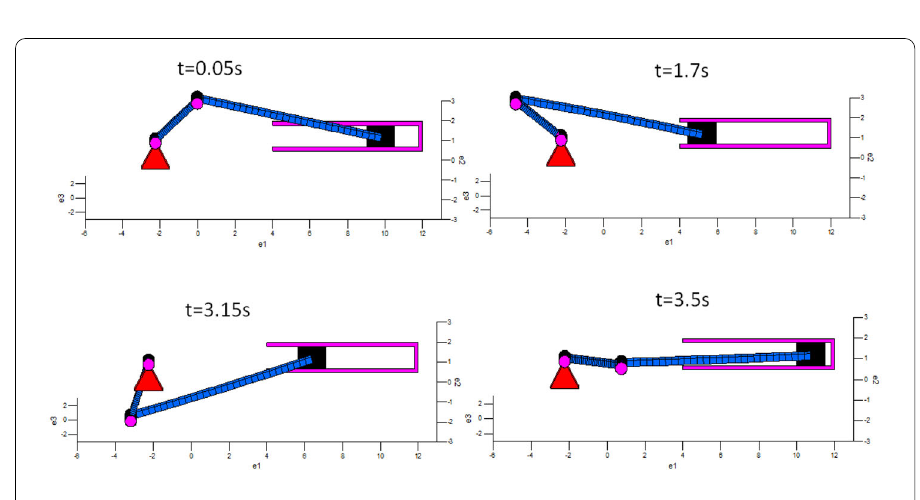
Fig. 32 Multi-body snap-shots